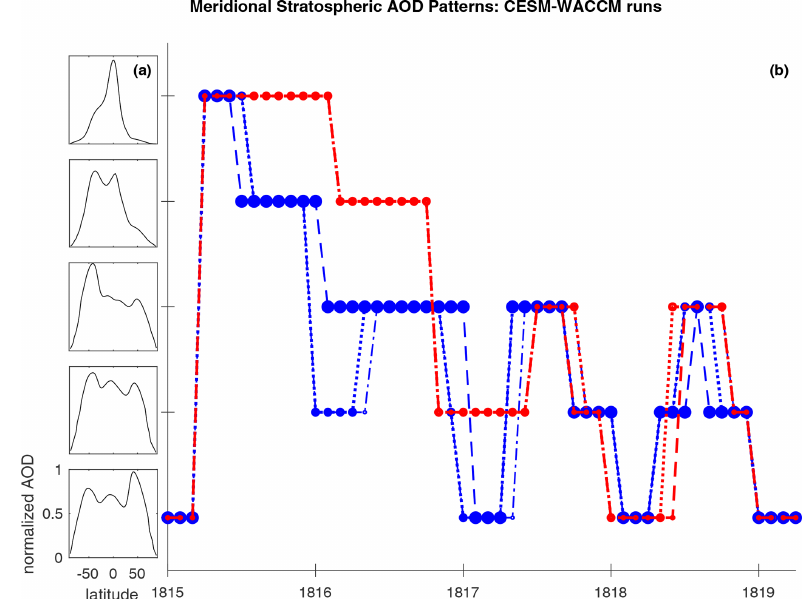
Figure D2. Time evolution of stratospheric meridional circulation patterns of aerosol in terms of AOD for the five CESM-WACCM ensemble runs. This is presented in the same format as Fig. D1 except the meridional AOD patterns in (a) are now derived from only the CESM- WACCM ensemble runs when training the SOM. (b) Time evolution of CESM-WACCM ensemble runs using the easterly QBO forcing observed during 1982 (red) and easterly QBO forcing of 1991 (blue) mapping to which characteristic pattern in (a) best represents the run at each